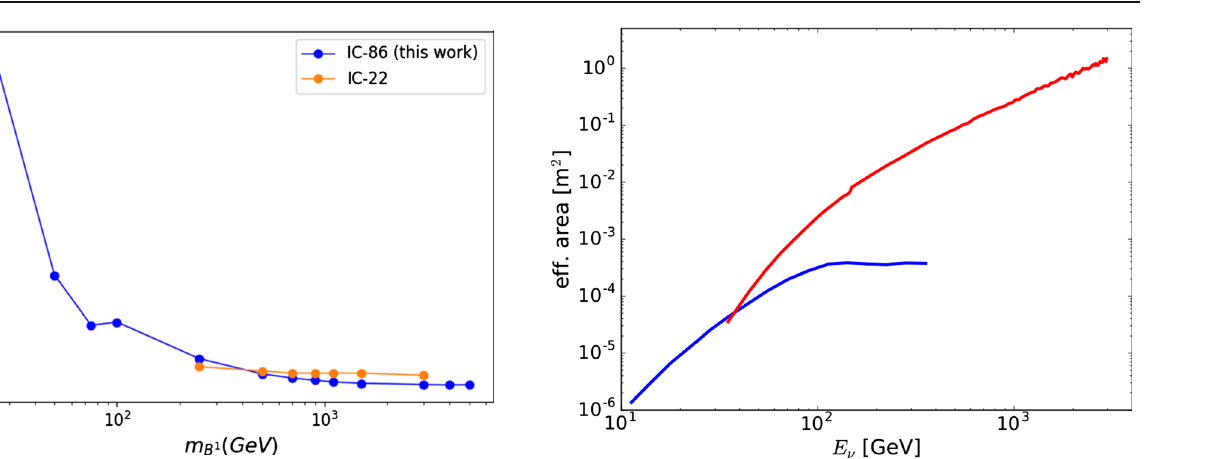
Fig. 3 The combined muon and anti-muon neutrino effective area for both the DeepCore (blue) and main IceCube array (red) for horizontally arriving neutrinos as a function of the neutrino energy. Uncertainties are not shown, but they can be as large as 30%. Source: Ref.